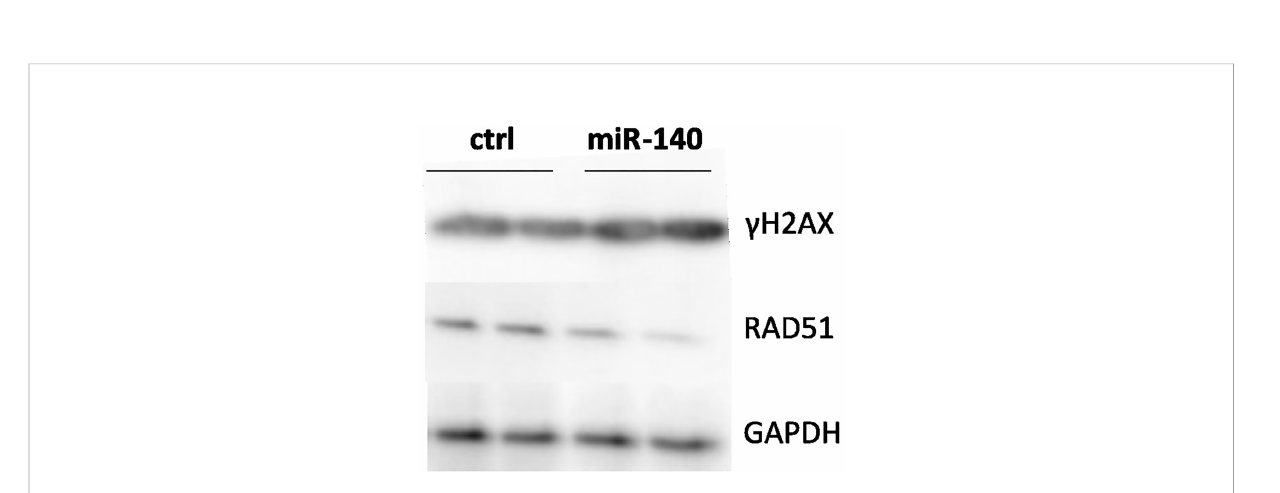
FIGURE 4 Effect of miR-140 on markers of DSBs. Western blotting analysis of cells transiently transfected with miR-140 showed decreased protein levels of RAD51 and increased levels of g H2AX. DSBs, double-strand